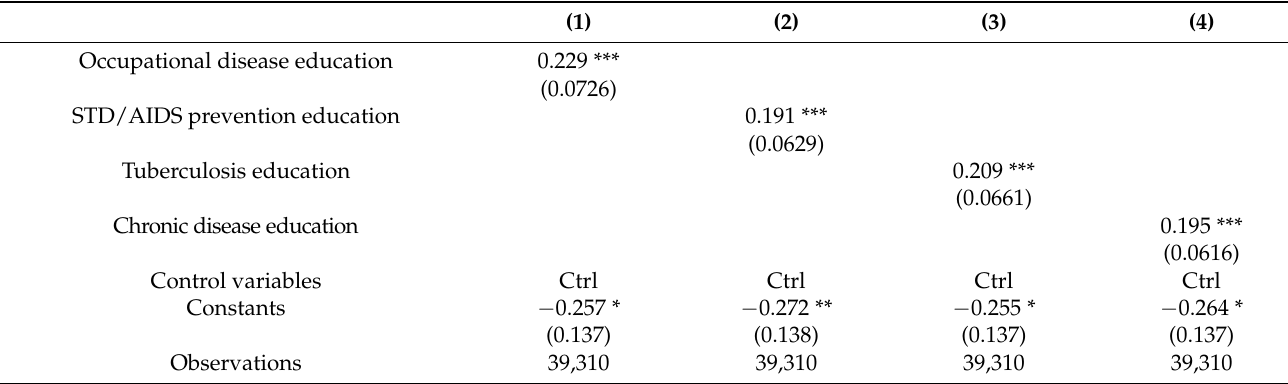
Table 6. Classification based on different types of disease